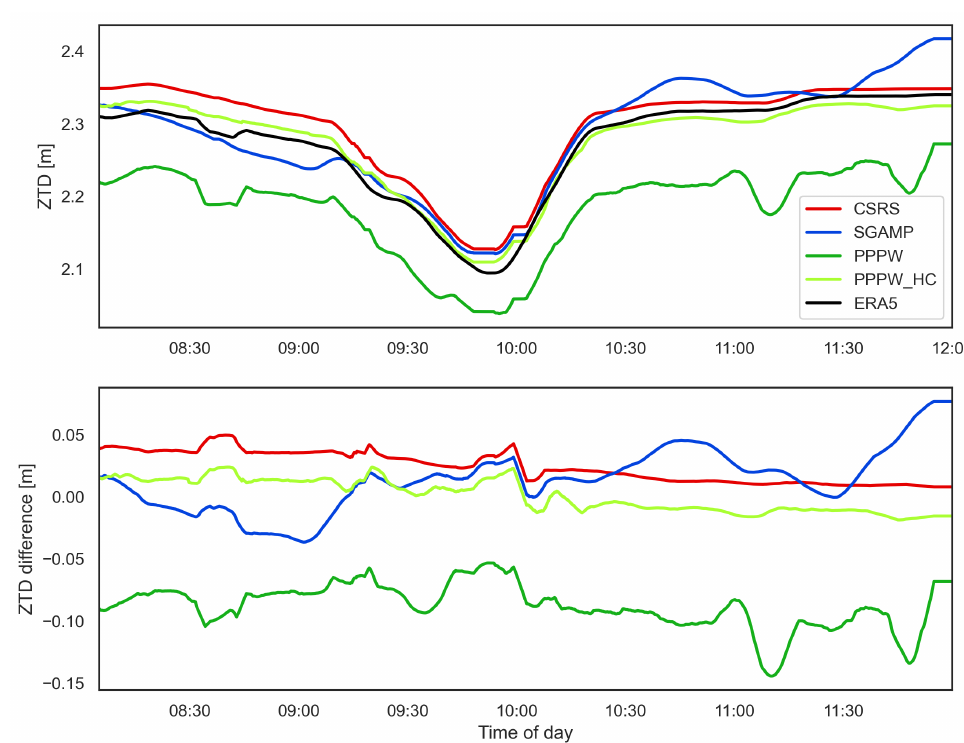
Figure 5. Comparison between the estimated GNSS-ZTD (CSRS-PPP (red), SGAMP (blue), PPP- Wizard (green), and PPPW-HC (lime)) and ERA-ZTD (black) for CS1. Top : ZTD, bottom : differences between GNSS-ZTD with respect to